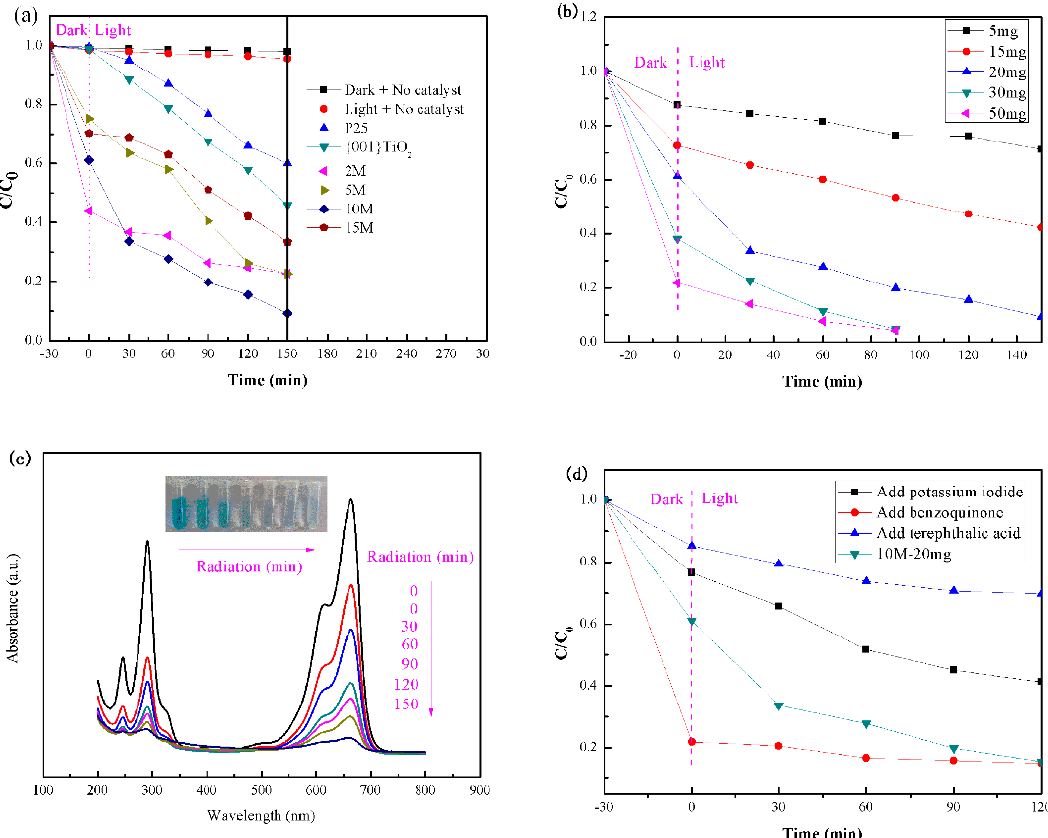
Figure 8. Degradation diagram of the prepared samples for methylene blue. ( a ) Photocatalytic performance of MB samples; ( b ) the effect of the different amount of 10 M samples on methylene blue; ( c ) UV-vis absorption spectral changes with photocatalytic degradation time of MB with the 20 mg 10 M sample; ( d ) radical-scavenging experiments of the 10 M sample.